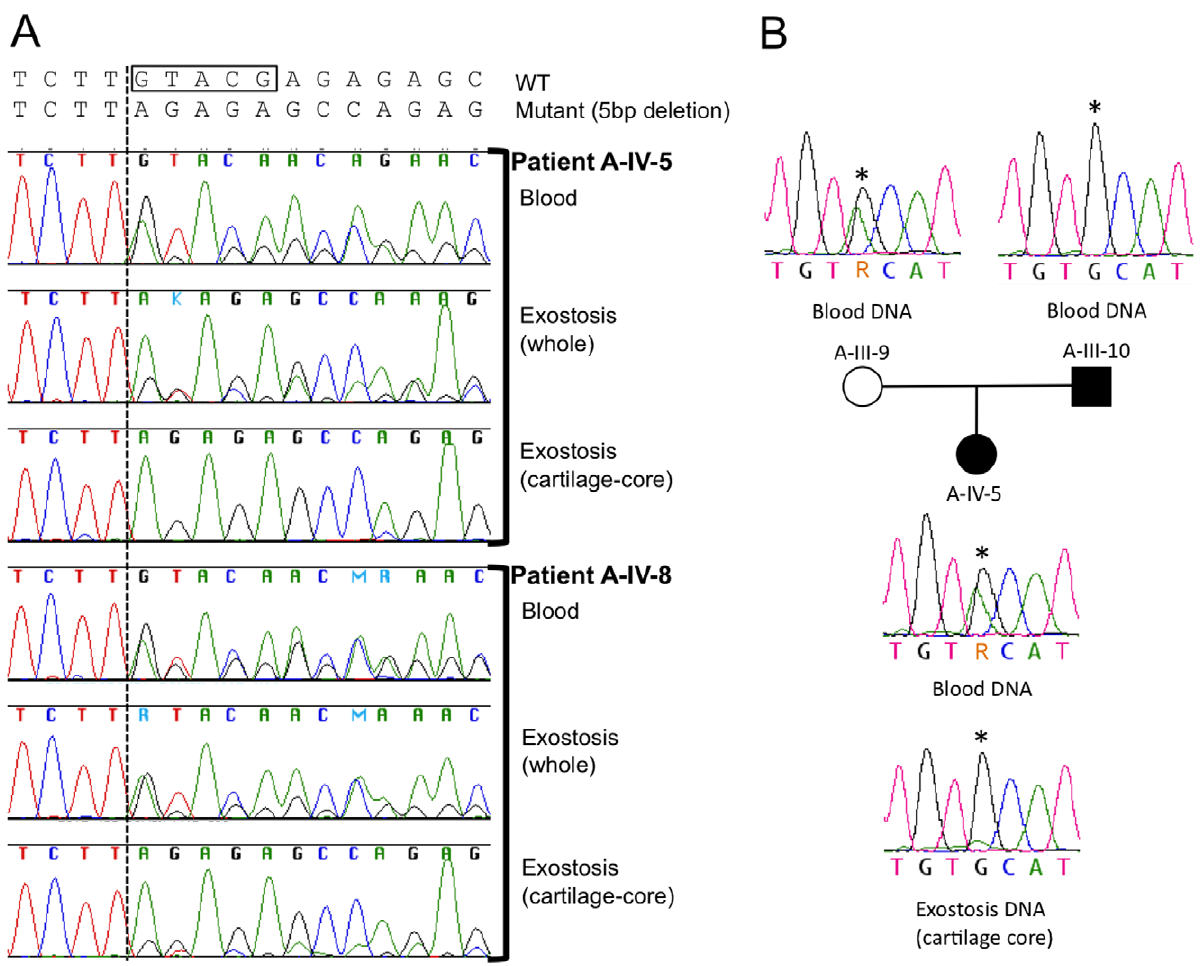
Figure 4. Loss of the wild-type PTPN11 allele in the cartilage of two exostoses. (A) Electropherograms of PCR amplified template DNA that had been extracted from whole blood, a section of an exostosis, or the cartilage core of the same exostosis. Exostoses were available from patients A- IV-5 and A-IV-8. The site of the 5 bp deletion in exon 4 of PTPN11 in both patients is indicated with a box. Note that that the heights of the peaks corresponding to the mutant sequence are markedly reduced in amplimers from the cartilage-core compared to amplimers from blood or from a section that contains cartilage, bone and fibrous tissue. This is consistent with loss-of-heterozygosity in the cartilage component of the exostoses. (B) Electropherograms of PCR amplified template DNA extracted from blood from participants A-III-9, A-III-10 and A-IV-5, as well as DNA extracted from the cartilage core of the exostosis from participant A-IV-5 shown in (A). Blood DNA electropherograms indicate that participants A-III-9 and A-IV-10 are heterozygous at a position (asterisk) in intron 11 of PTPN11 . This is the site of a known common polymorphism (rs41279092). Exostosis cartilage DNA electropherograms have a reduced adenine peak height at this position. This suggests that the wild-type PTPN11 allele inherited from the unaffected parent (A-III-9), which carries an adenine at this position, has been lost in cells that contribute to formation of the exostosis’ cartilage